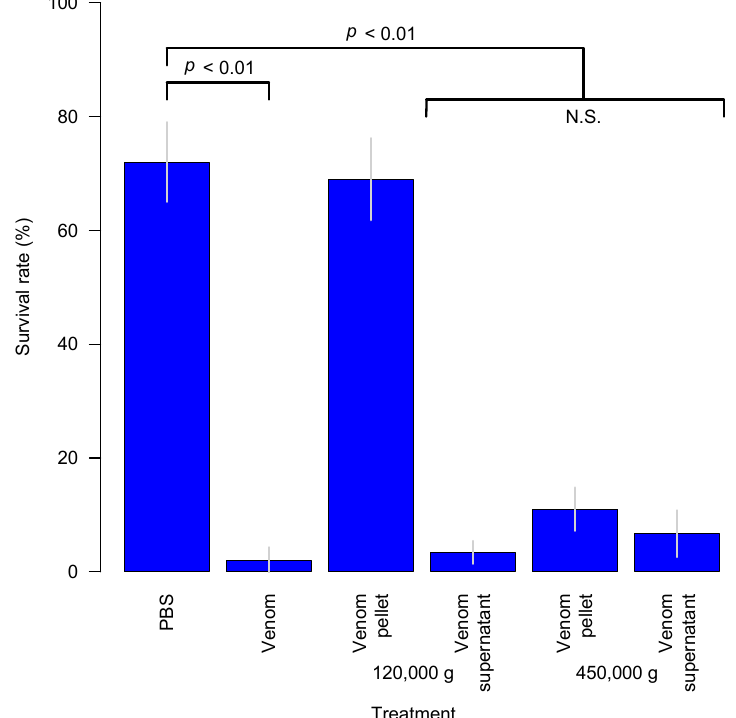
Figure 7. Effects of Asobara japonica venom and products of ultracentrifugation on survivorship of D. melanogaster larvae one day after injection. (Source: redrawn based on [149] under the terms of Creative Commons Attribution Licence CC-BY 4.0 via PLoS ONE ). N.S.: not significant.